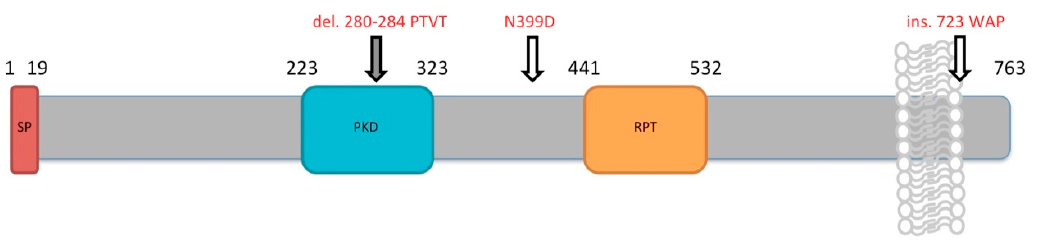
Figure 11. A schematic of chicken premelanosome protein (PMEL). A wild-type chicken has black, red, and orange plumage. The two mutations that cause the dominant white phenotype, i.e., plumage that is stark white, are N399D and a three amino acid insertion (residues tryptophan-alanine-proline, WAP) at amino acid 723. An additional deletion of four amino acids (residues proline-threonine-valine-threonine, PTVT), in the polycystic kidney domain (PKD), in addition to the two mutations found in the dominant white chicken, cause the smoky phenotype, i.e., plumage that is dark gray in colour.